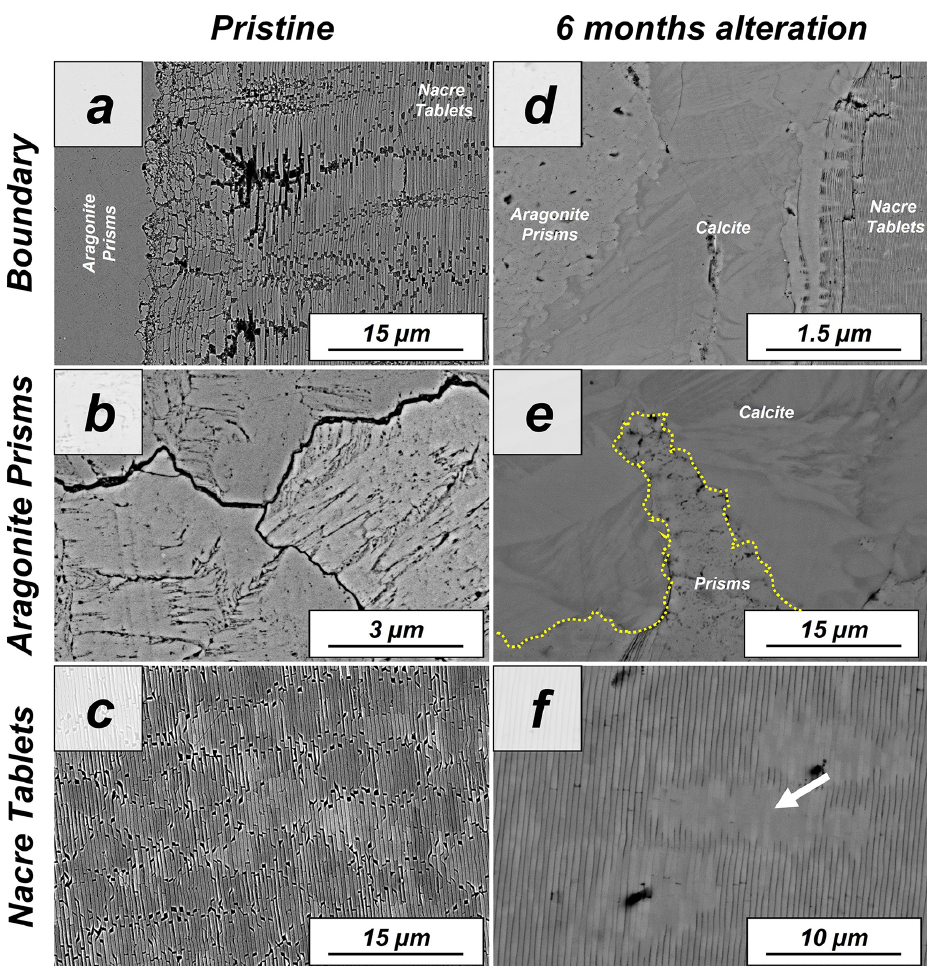
Figure A8. FE-SEM images depicting the internal structure of (a–c) pristine and of (d–f) altered shells of the gastropod Haliotis ovina . (a) Haliotis ovina shells consist of two layers: (b) an outer layer formed of aragonite prisms up to 3µm in width and (c) an inner layer next to the soft tissue of the animal consisting of columnar assemblies of nacre tablets. (d–f) Hydrothermal alteration of Haliotis ovina shells for 6 months at 80 ◦ C in a burial fluid leads to the formation of new calcite crystals in the prismatic layer. These calcite crystals are concentrated at the interphase between the prisms and the nacre tablets. The aragonitic nacre tablets do not show transformation into calcite. However, tablet amalgamation is well observable as the edges and margins within stacks of tablets become blurred (white arrow in panel d ).